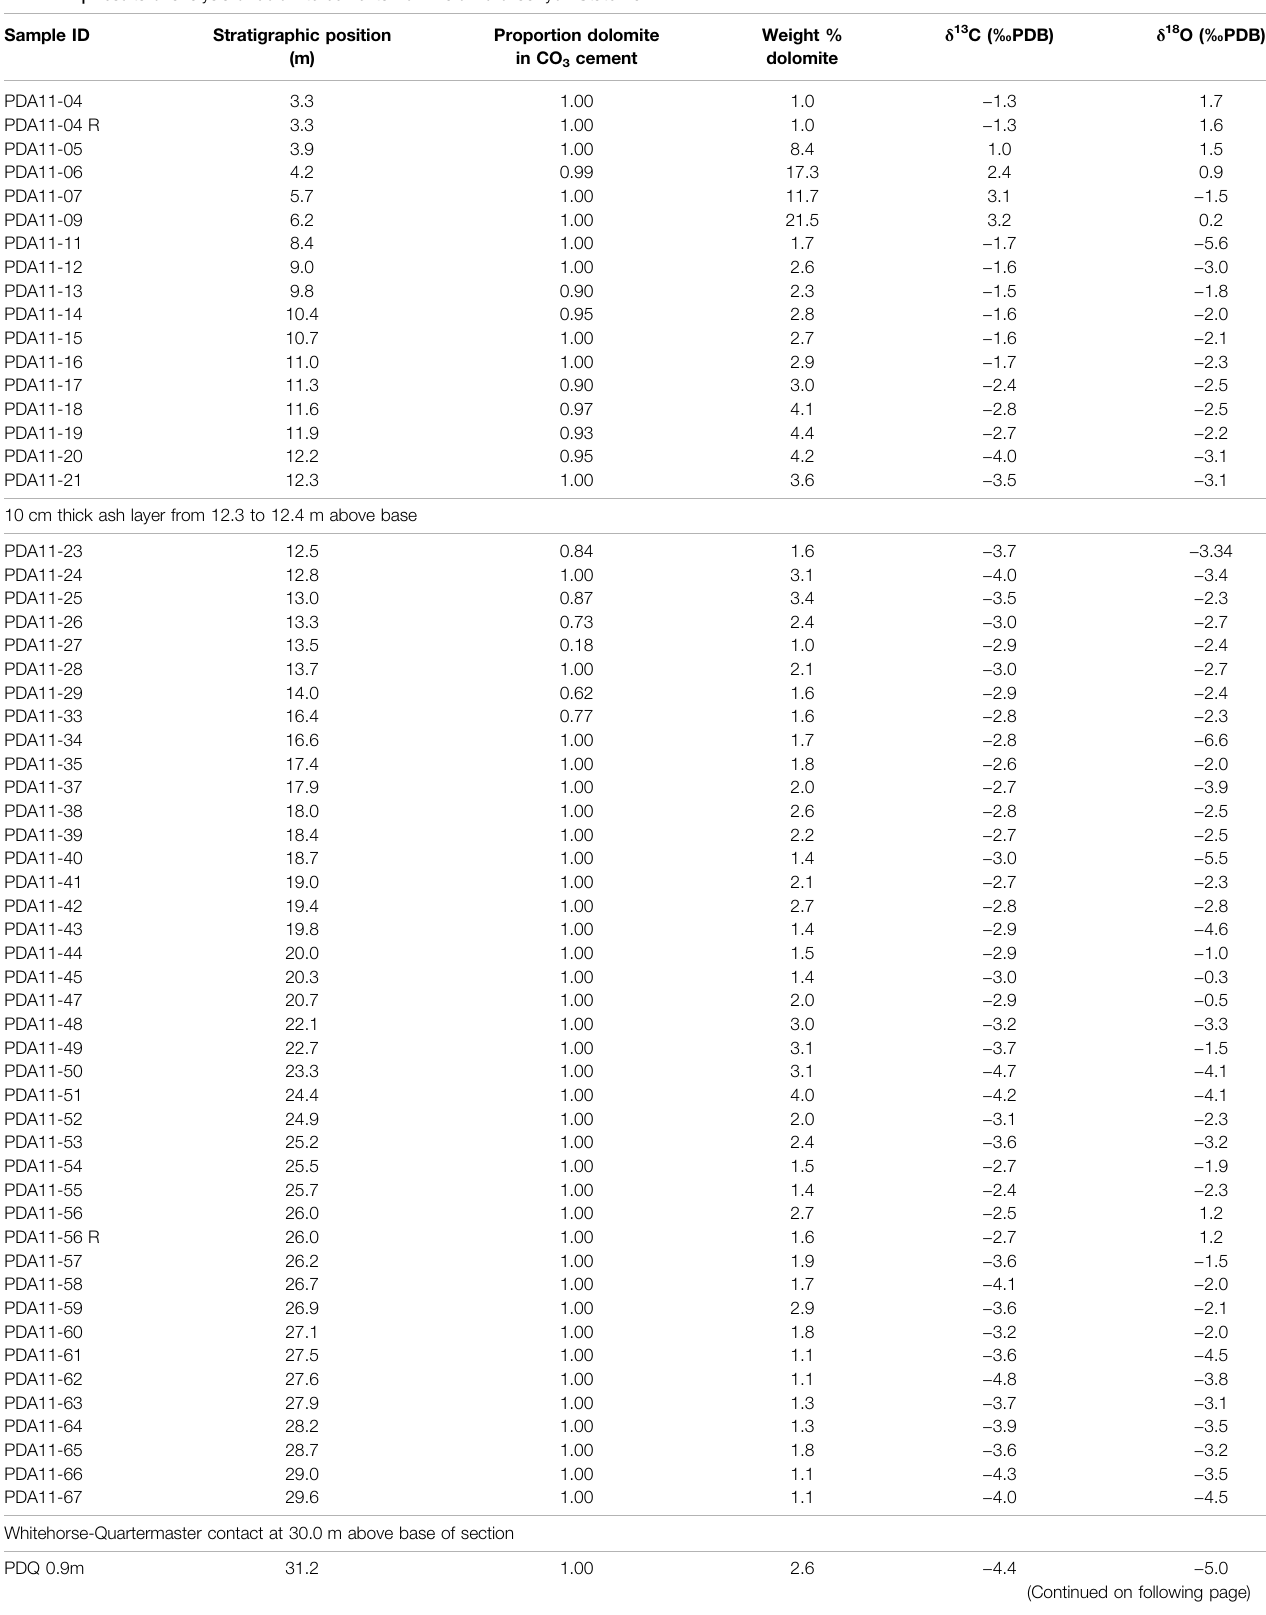
TABLE 7 | Results of analysis of dolomite cements from Palo Duro Canyon State Park. Sample